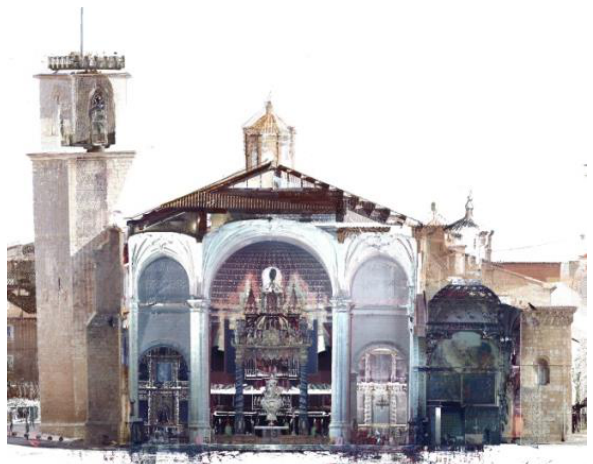
Figure 5. Orthophoto of the tower elevation.